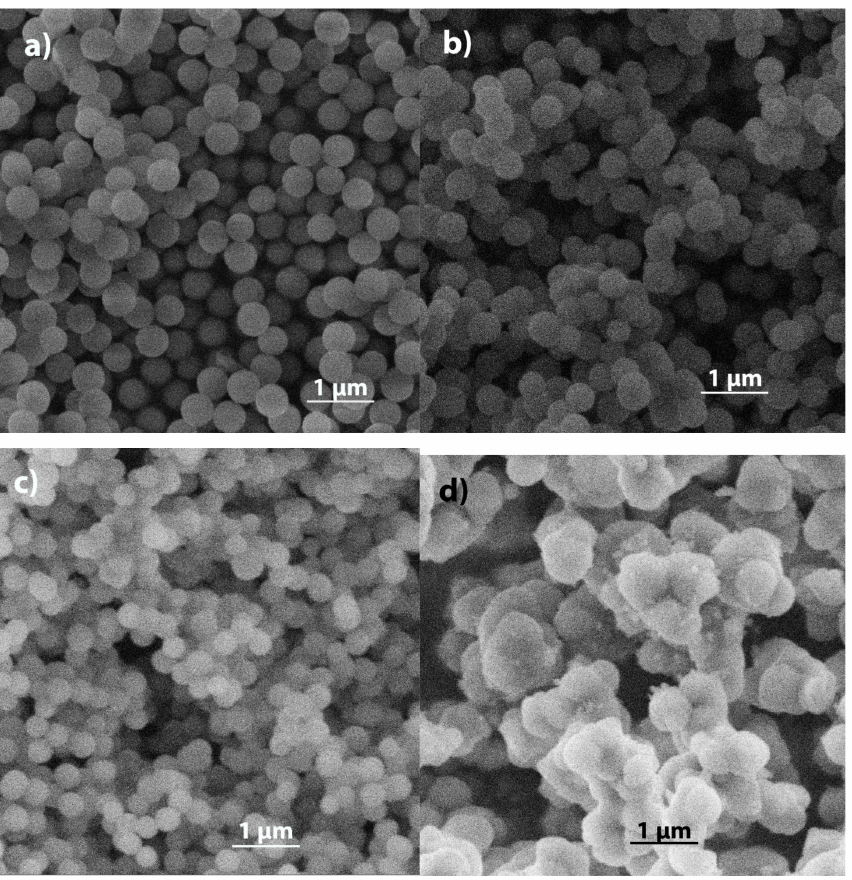
Figure 2. Scanning electron microscopy SiO 2 –C 3 H 6 –NH 2 : ( a ) NH 2 -0.4-0.1; ( b ) NH 2 -0.3-0.2; ( c ) NH 2 -0.25-0.25; ( d ) NH 2 -0.2-0.3. Sample NH 2 -0.4-0.1 had a spherical particle shape. Almost non-aggregated